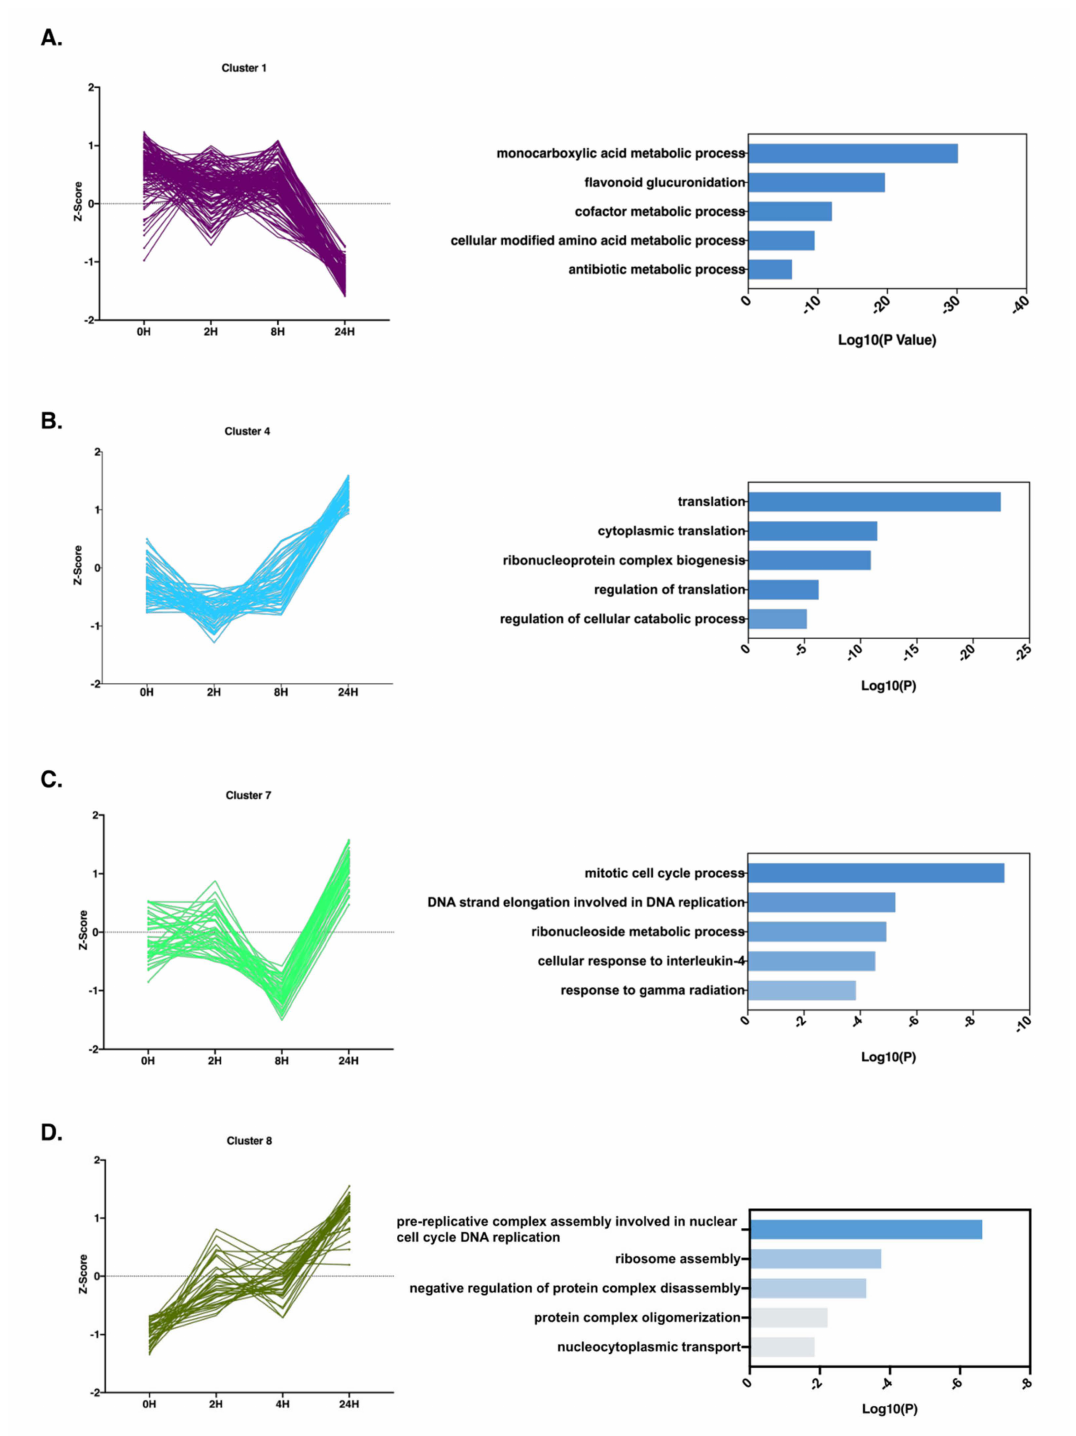
Figure 3. Protein clustering is correlated with protein function. ( A – D ) Protein dynamic regulation patterns and correspon- dent biological processes. Individual proteins from specific clusters were plotted based on their Z-scored Log2(LFQ) at each time point, and points were connected by a line. The top five enriched biological processes with the highest –Log(P) values are shown for the proteins present in each